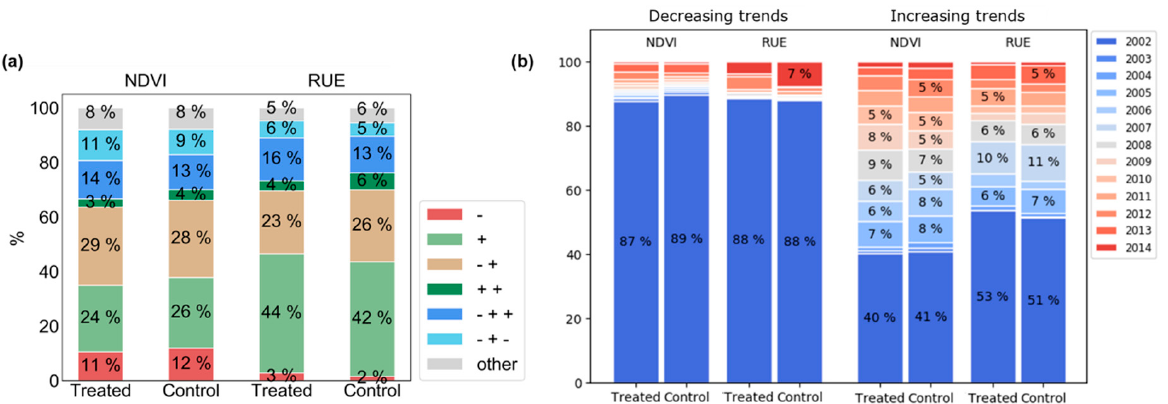
Figure 5. LandTrendr results for treatment and control areas, respectively; ( a ) Change types detected by LandTrendr with “+” indicating increasing and “-“decreasing trends. As the change types resulted from fitting either one, two or three segments into the time series, different combinations of trends existed. For example, while “-“ indicates a decreasing trend over the entire study period, “- + +” indicates one decreasing trend followed by two increasing trends; ( b ) Timing of NDVI and RUE trends.